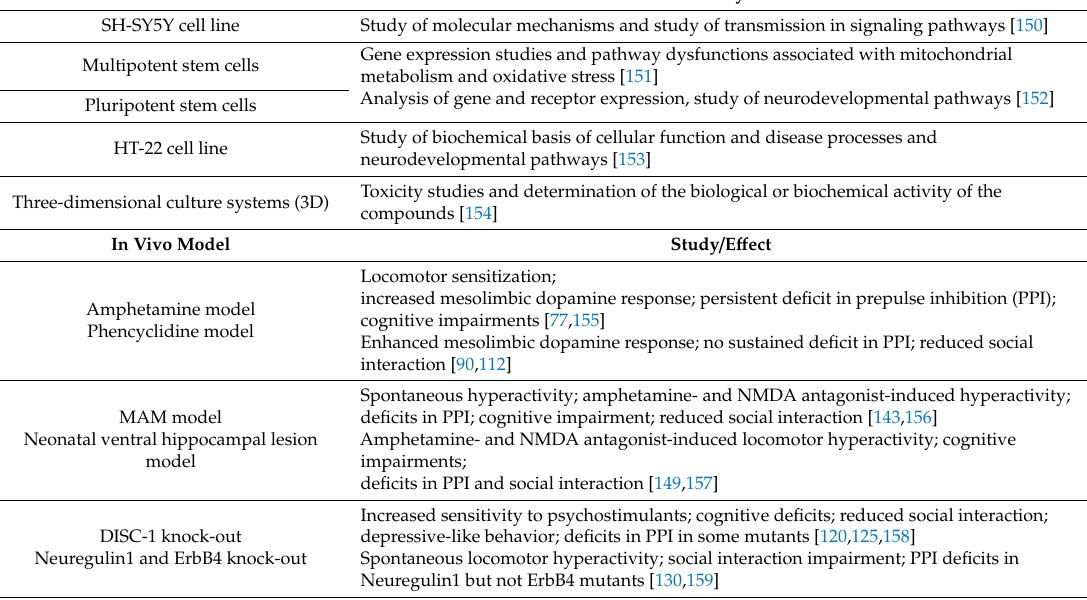
Table 1. Examples of studies using in vitro and in vivo models of SZ (partially elaborated based on reference